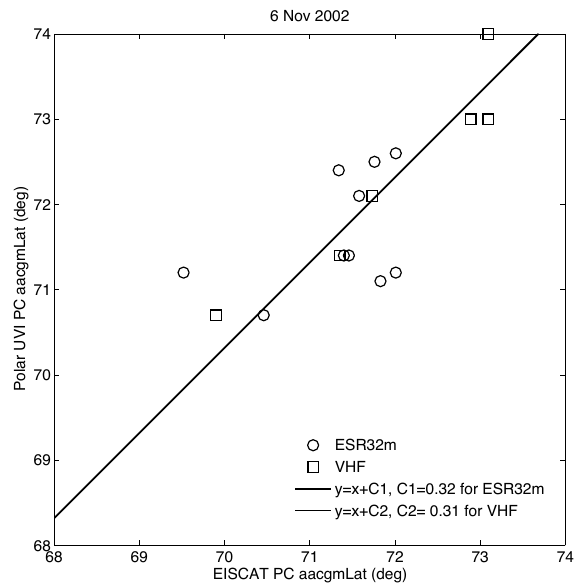
Fig. 5. Comparison of polar cap boundary latitude by Polar UVI and ESR 32m (circles) as well as Polar UVI and VHF (squares). Linear fits to both of the curves are shown, but they overlap. For details, see text.